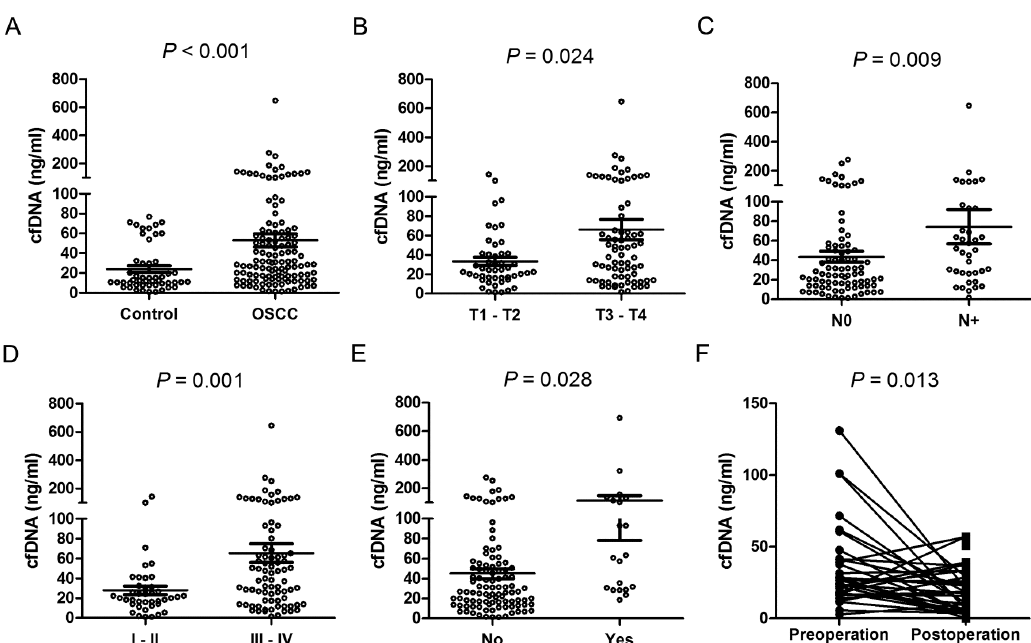
Figure 2. Comparison of cell free DNA (cfDNA) plasma levels. Scatter dot plots with mean ± SD computed by Mann–Whitney test: ( A ) Healthy controls vs. preoperative plasma cfDNA levels in patients with OSCC. ( B ) pre-operative plasma cfDNA levels and different tumor sizes ( C ), Absence or presence of neck lymph node metastasis. ( D ) early and late stage carcinoma and ( E ) lymphovascular invasion status. ( F ) pre-operative and post-operative plasma samples.